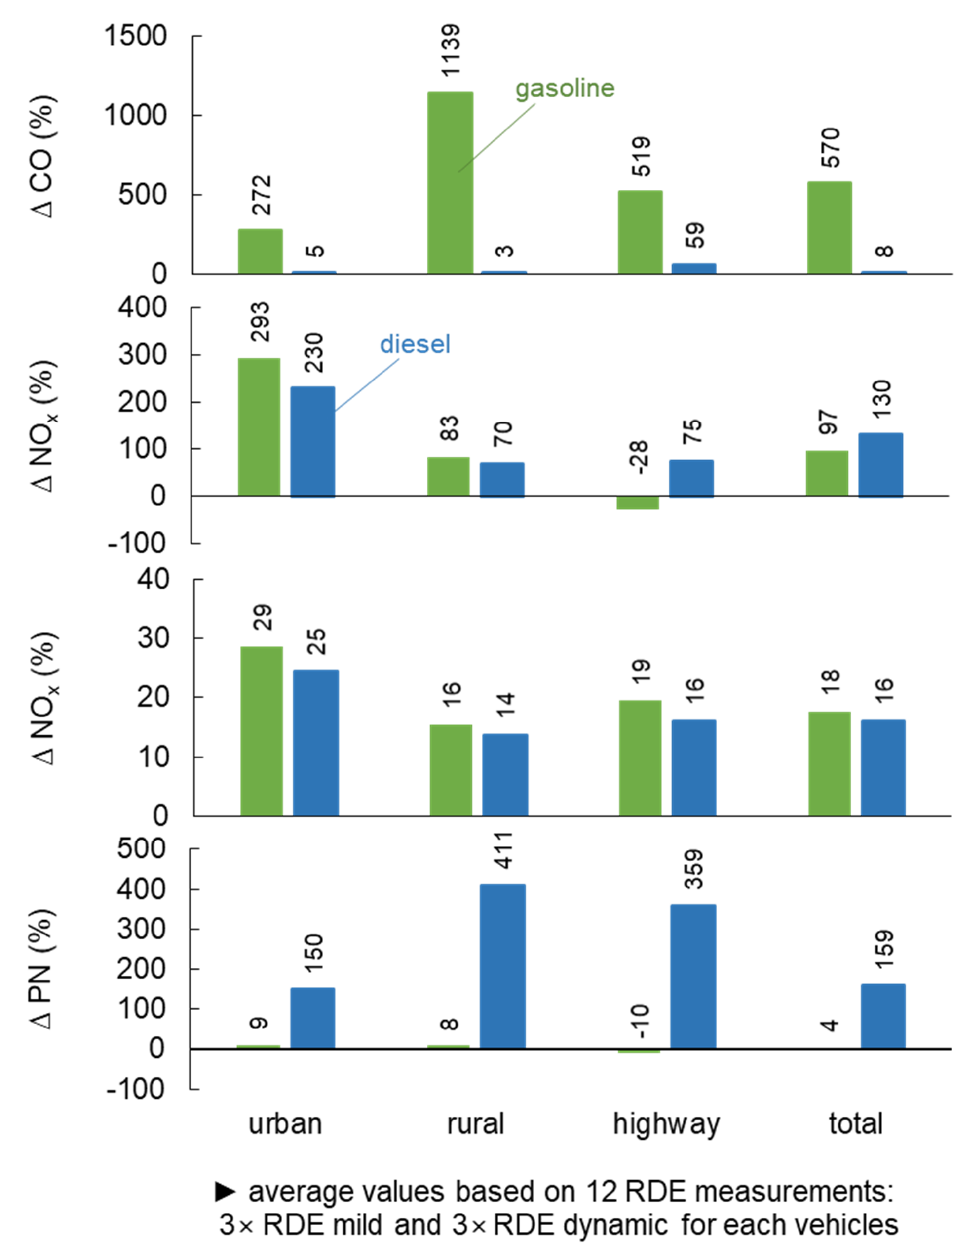
Figure 9. Variations of RDE between the mild and the dynamic driving styles, vehicle 1, gasoline vehicle 2, and vehicle 2, diesel.